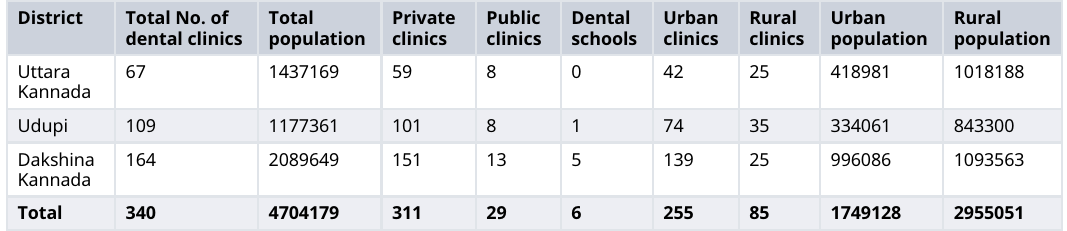
Table 1. District-wise distribution of dental workforce by practice type and